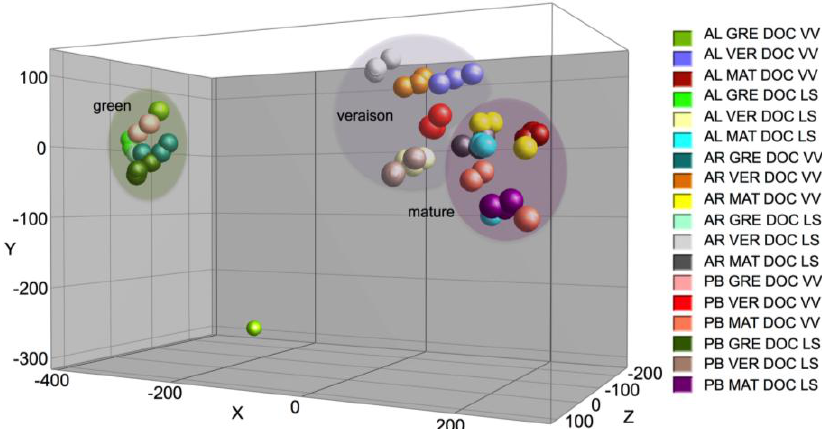
Figure 1. Principal component analysis (PCA) plot of Alvarinho (AL), Arinto (AR) and Padeiro de Basto (PB) metabolites in grape berries from the DOC VV (Vinho Verde)